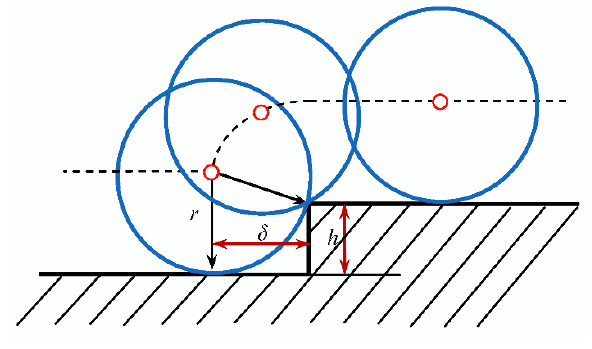
Figure 2. The step–road surface.